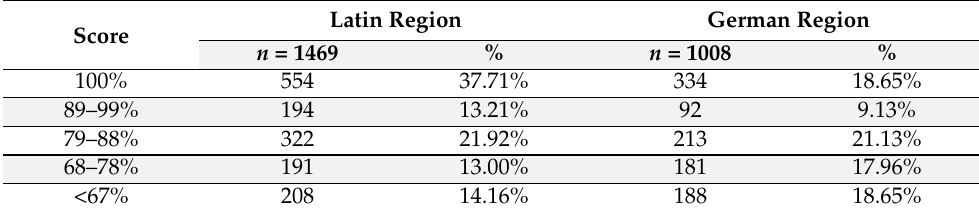
Table 3. Quality-of-care scores distribution by linguistic-geographic region.